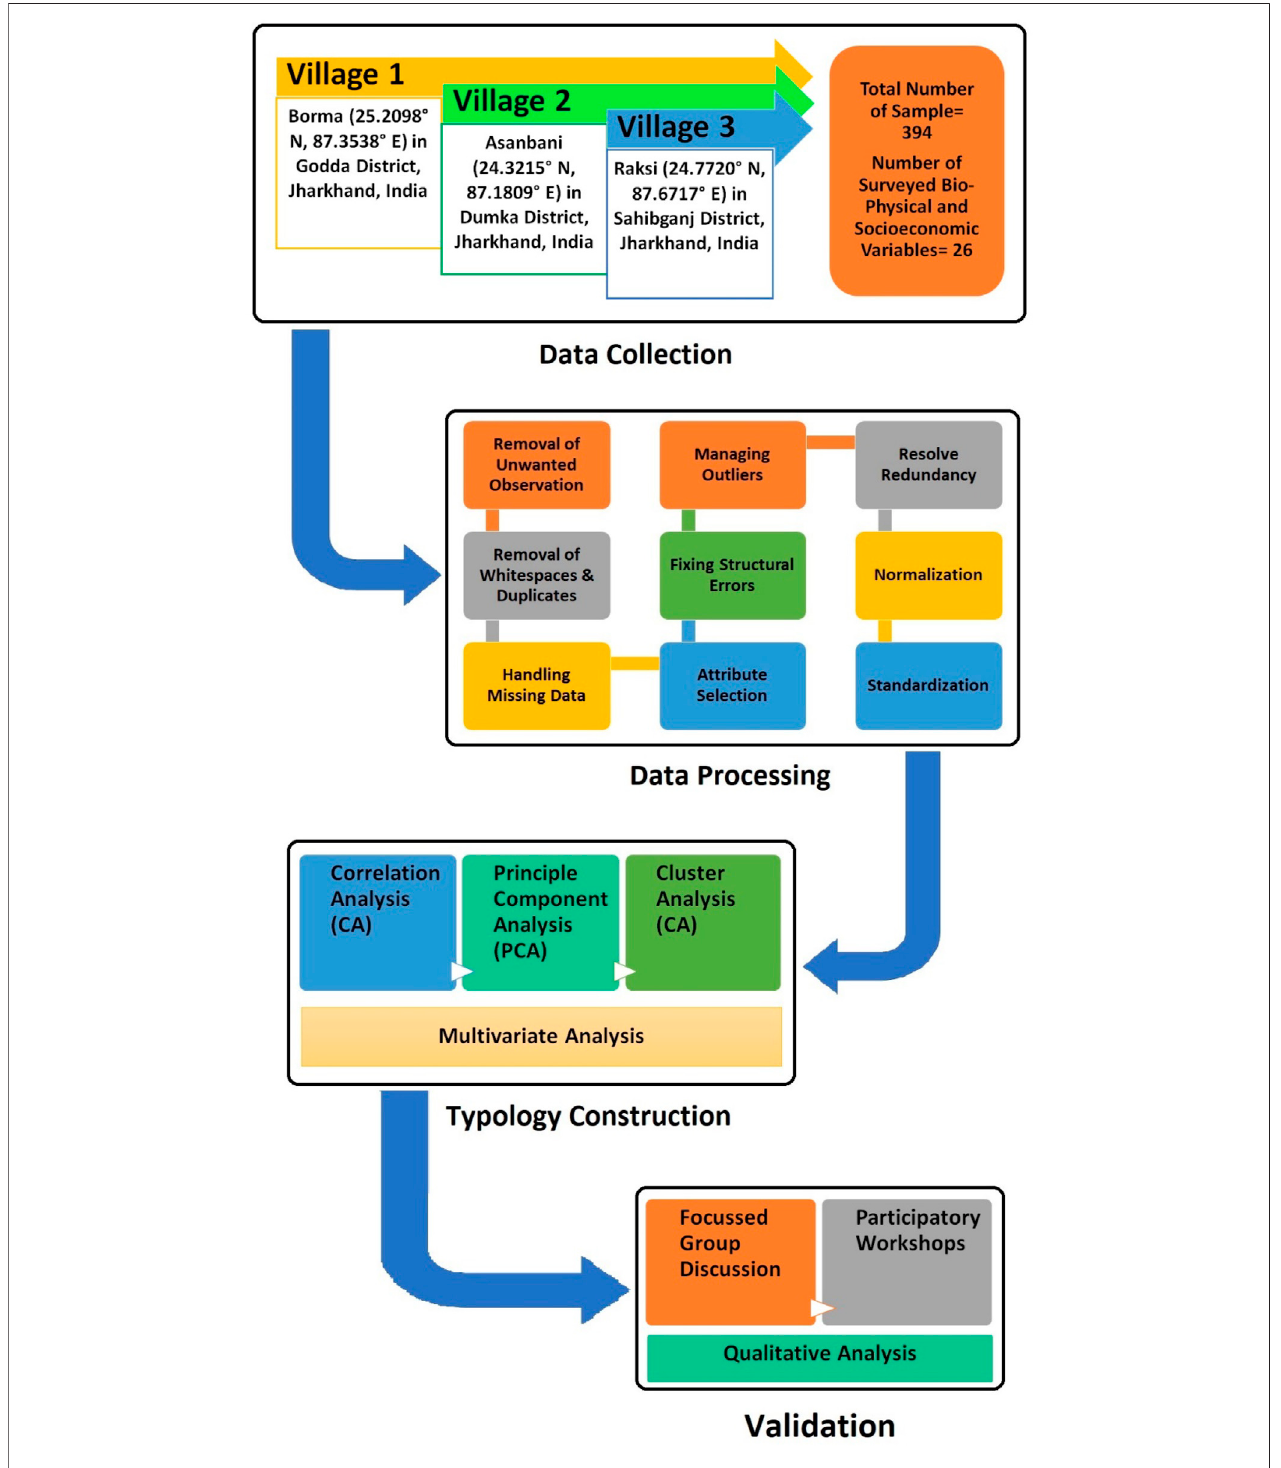
FIGURE 2 | Flowchart of methodology.